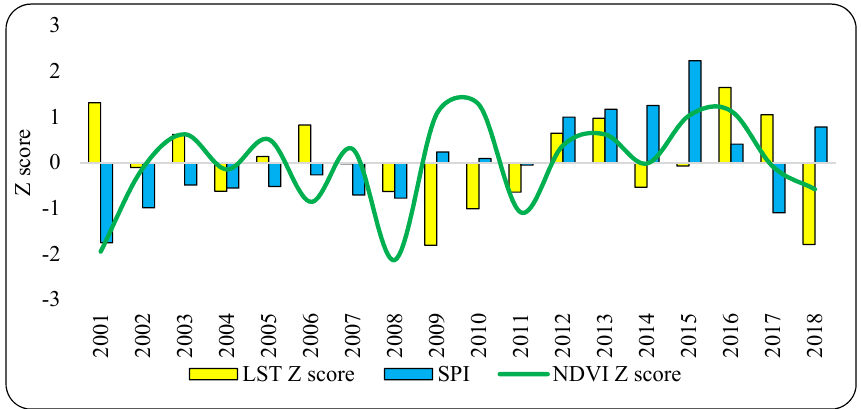
Figure 9. The relationship between anomaly of yearly vegetation coverage with the anomaly of annual precipitation and LST in Afghanistan between 2001 and 2018.